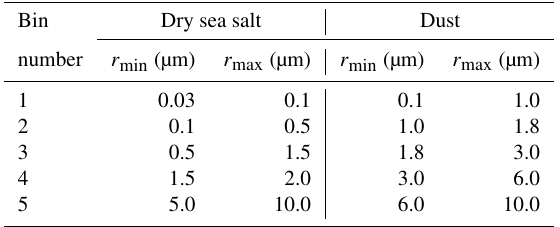
Table 5. Maximal and minimal radii of the particle size bins for dry sea salt and